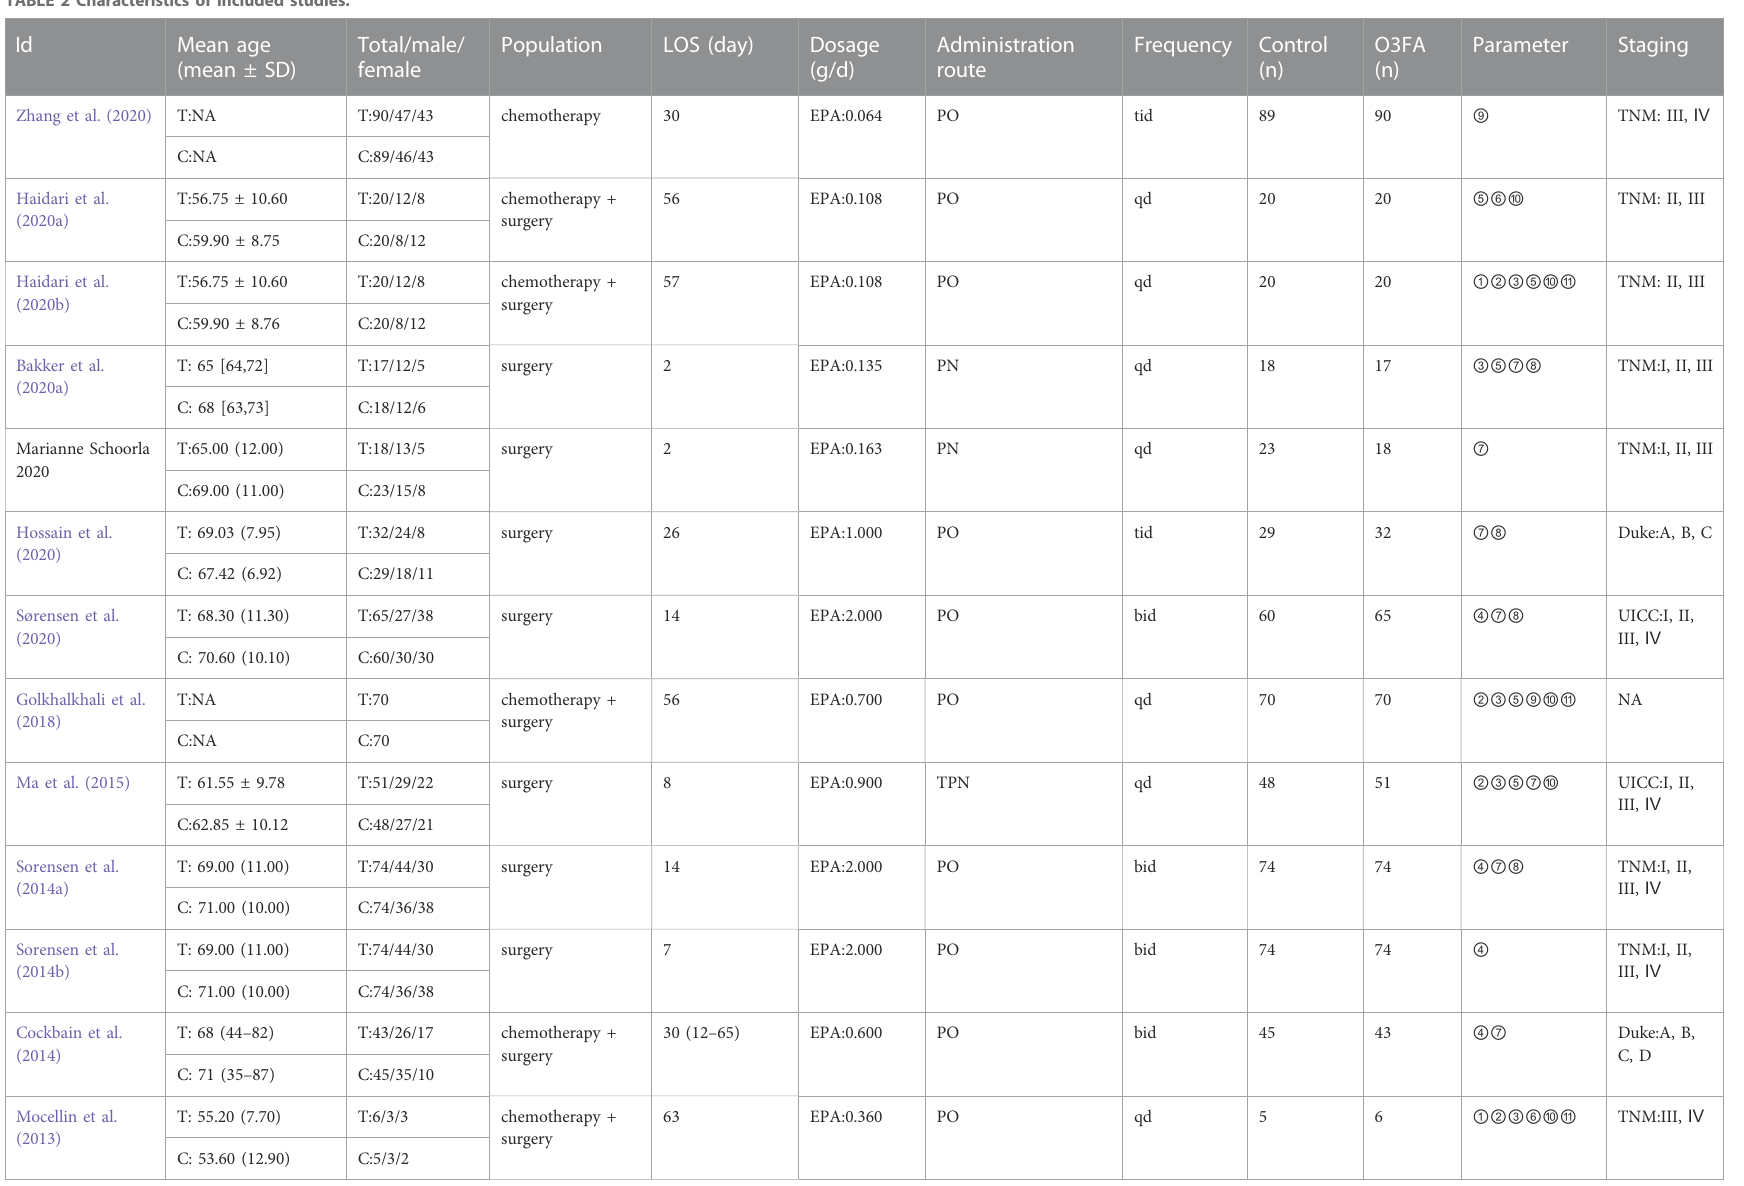
TABLE 2 Characteristics of included